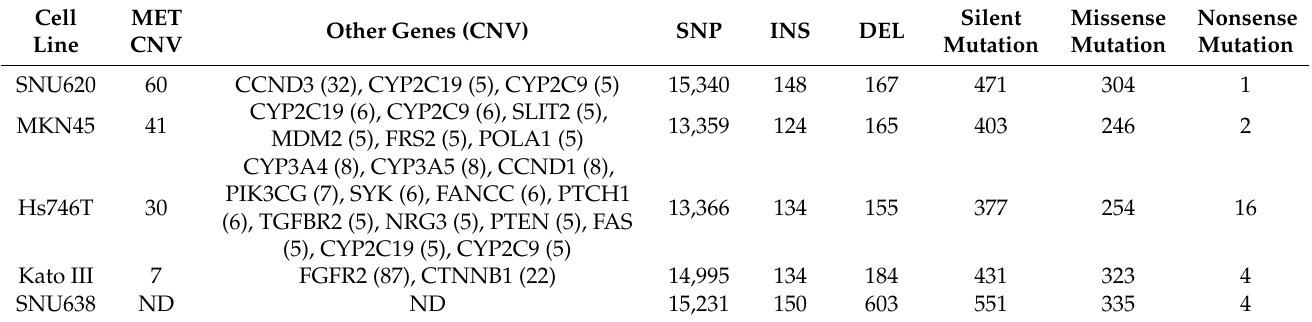
Table 2. Description and concomitant genomic alteration of individual